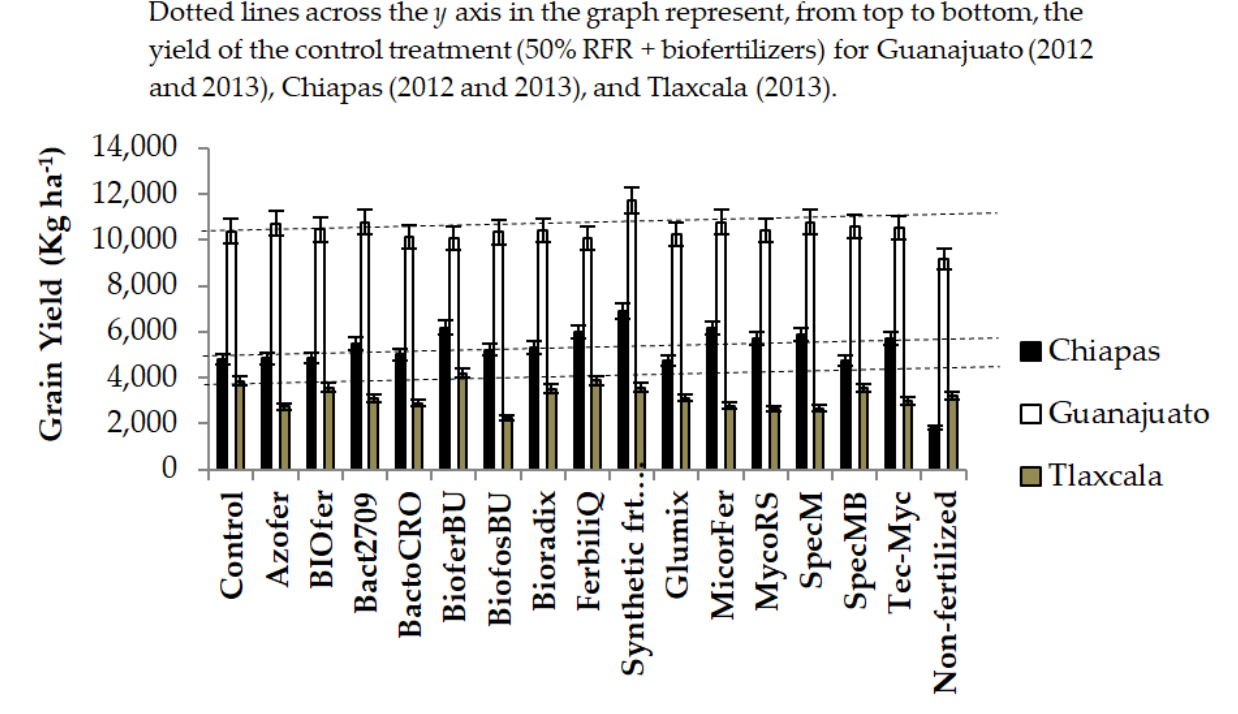
Figure 1. States × treatments interaction in three Mexican states (Group 1) to test the effectiveness of partially substituting synthetic fertilizers by biofertilizers.